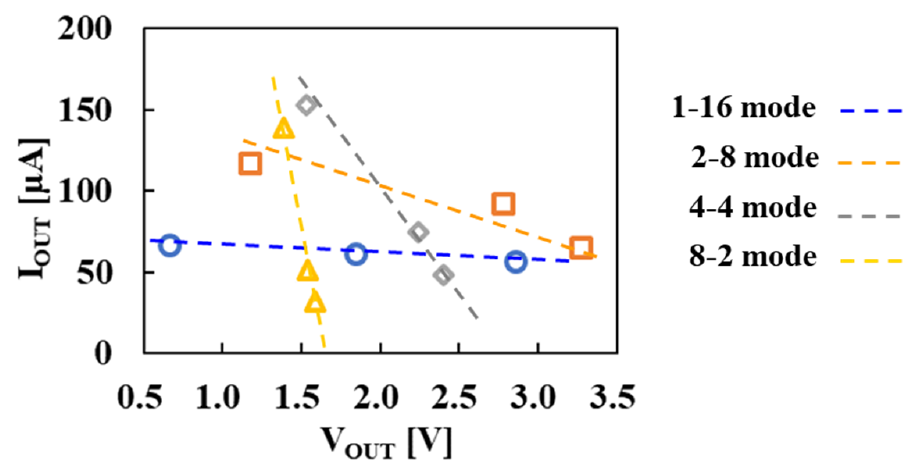
Figure 15. Measured V OUT – I OUT at V S of 0.6 V in four CP modes.